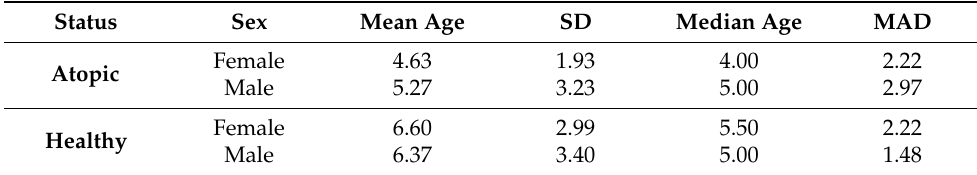
Table 1. The mean and median age of the